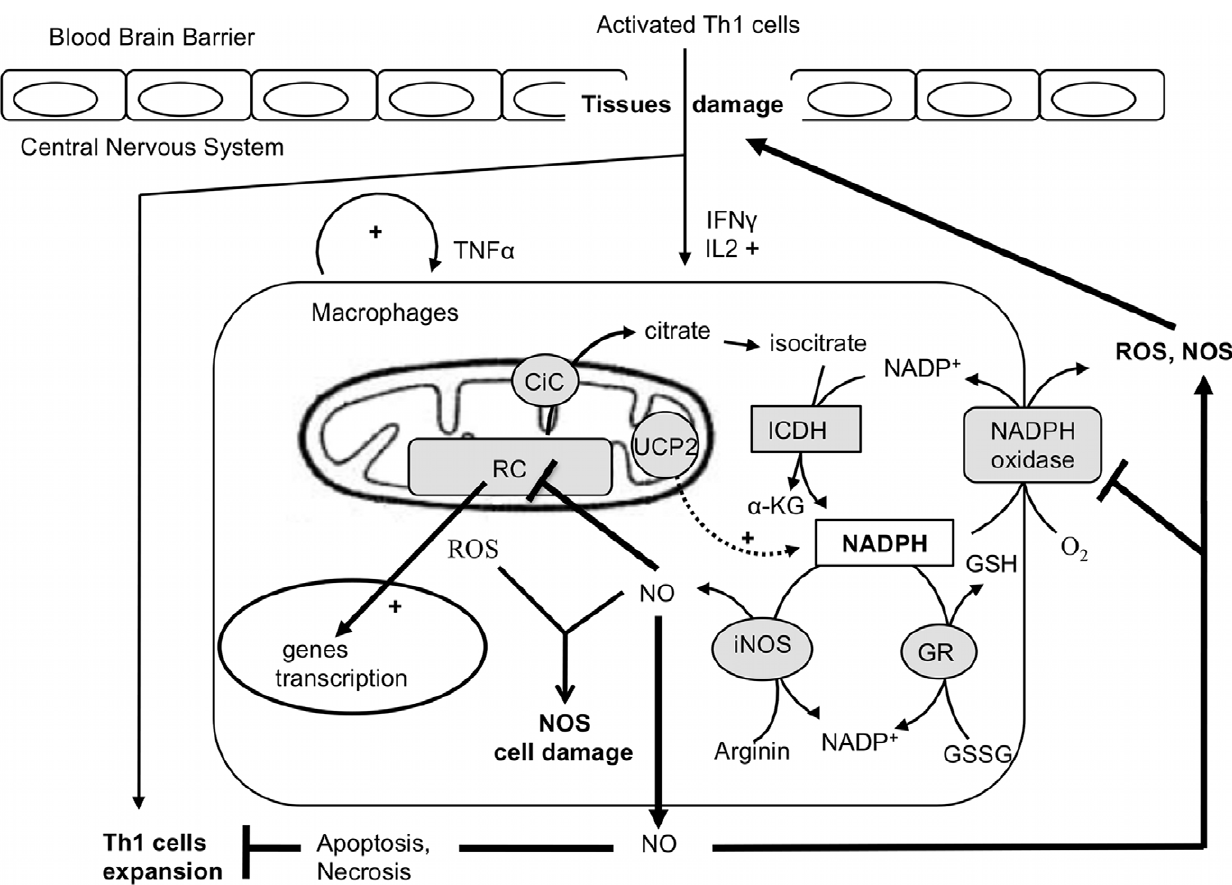
Figure 6. The redox balance in macrophages during inflammation induced by EAE. Once activated, Th1 cells enter the CNS and produce proinflamatory cytokines (IFN c , Il2) that stimulate resident macrophages. Inflammation is further increased with the autocrine production of TNF a by macrophages. At the cellular level, ROS production stimulates the expression of proinflammatory genes such as the NO synthase gene. In one hand, nitric oxide inhibits the respiratory chain (RC), which, in turn, increases the mitochondrial ROS production and consequently oxidative cell damage. In the other hand, NO prevent Th1 cell expansion and inhibits the NAPH oxidase enzyme, an essential ROS producer that trigger tissue damage and brain blood barrier destruction. At the molecular level, NADPH plays a pivotal function in the redox balance as substrate of the NADPH oxidase, the NO sytnhase (iNOS) and the gluthation reductase (GR). In this context, mitochondrial carriers, including UCP2, could modulate the availability of this substrate. For instance the citrate carrier supplies an additional source of cytosolic NADPH by exporting citrate that is further oxidized into alpha keto glutarat ( a -KG) by the cytosolic isocitrate dehydrogenase (ICDH).